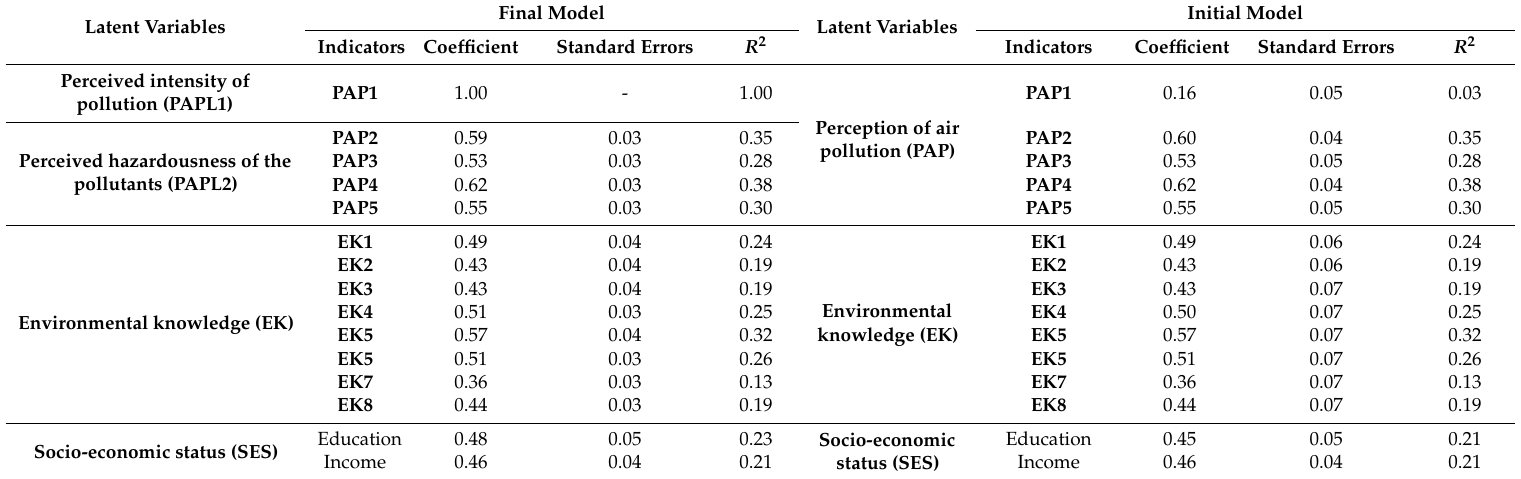
Table 3. The measurement models (standardized